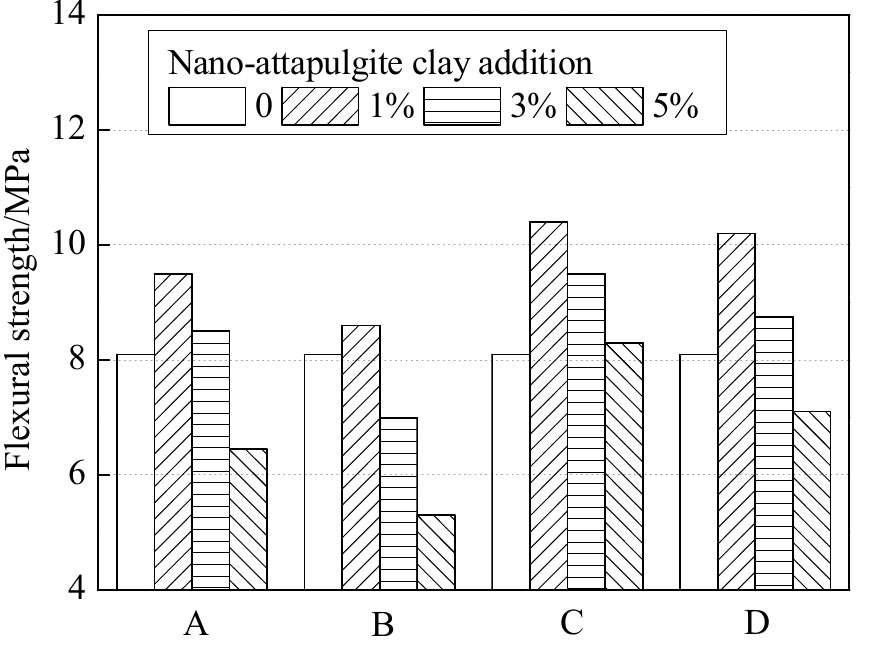
Figure 11. Flexural strength of cement paste with various NAC addition.